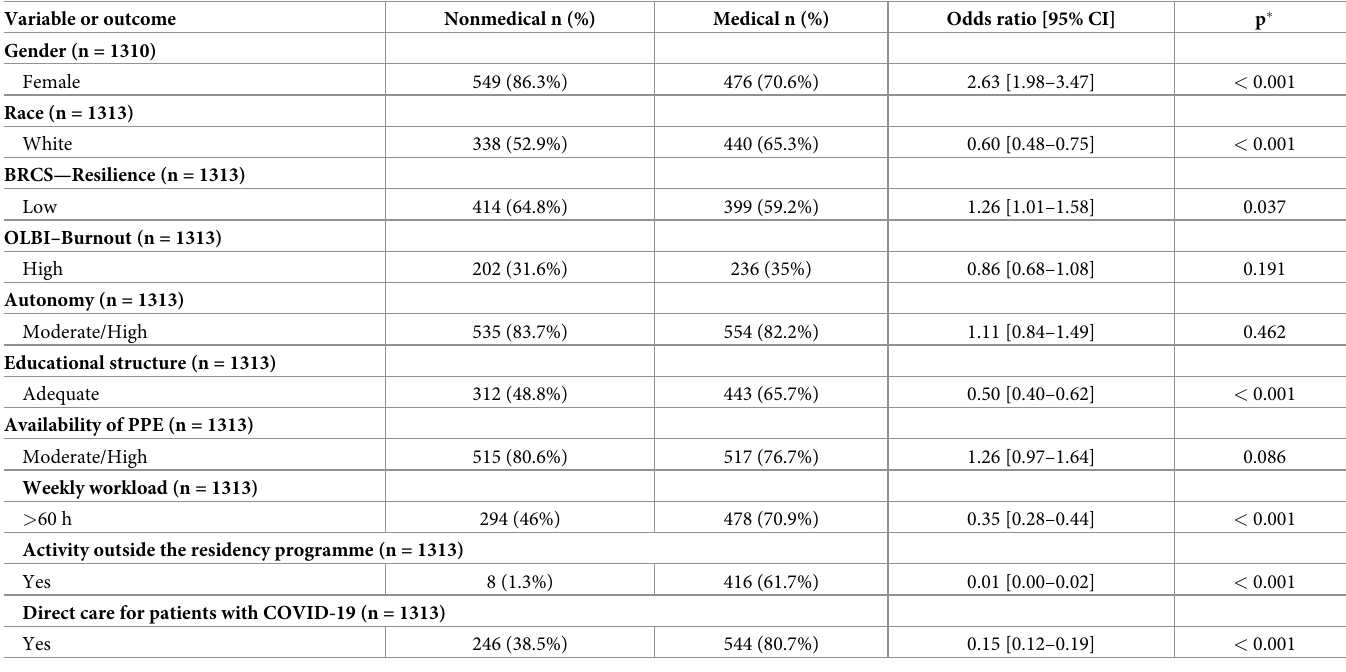
Table 3. Differences between medical residents and nonmedical residents regarding the various characteristics studied—bivariate analyses